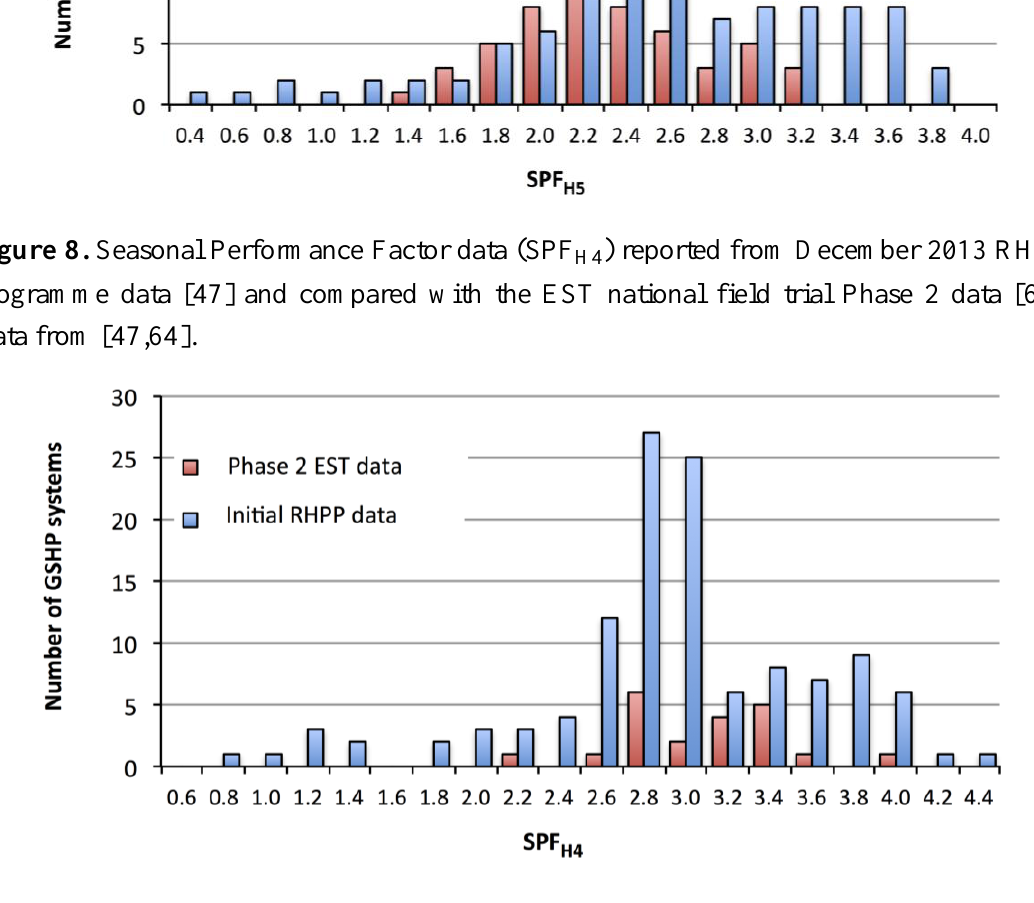
) reported from December 2013 RHPP H4